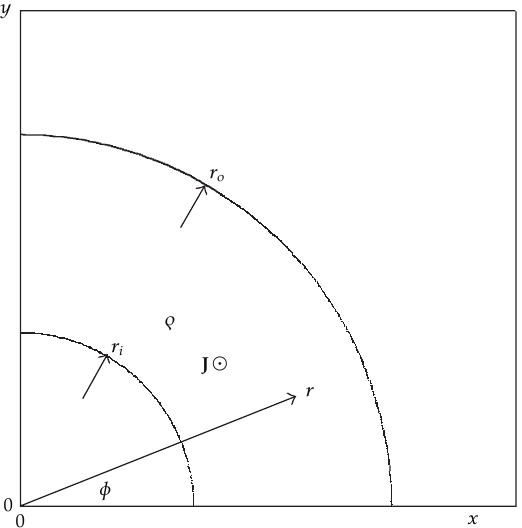
Figure 1: A quarter of the cross-section of tubular